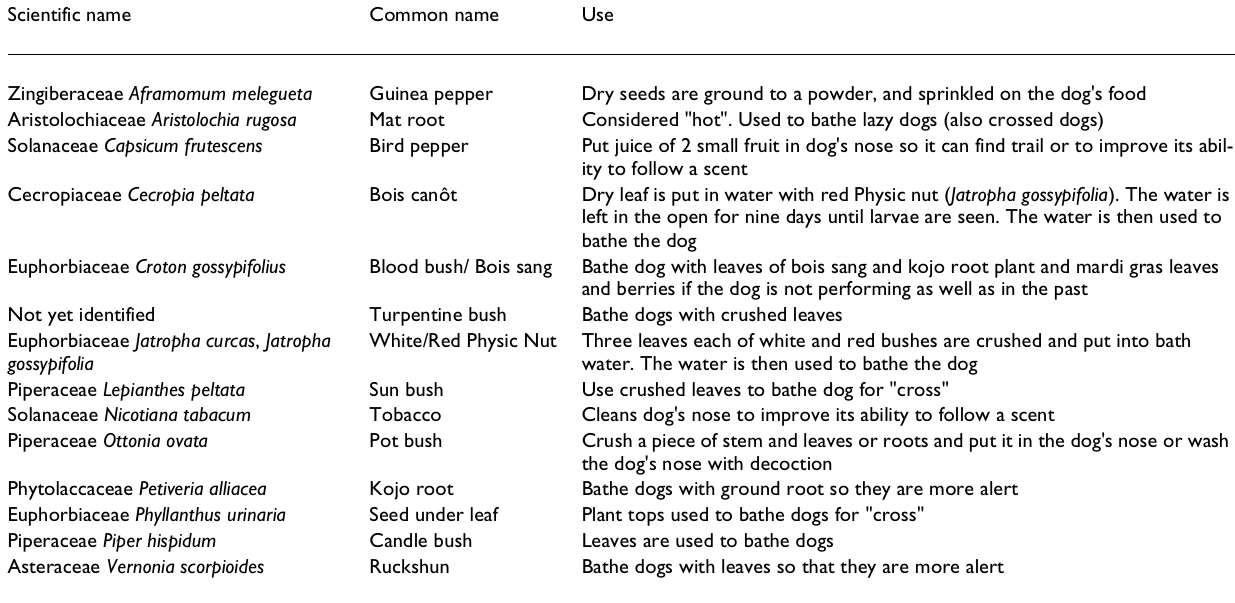
Table 1: Plants used for successful hunting (steaming, "crossed", dog's nose) Scientific